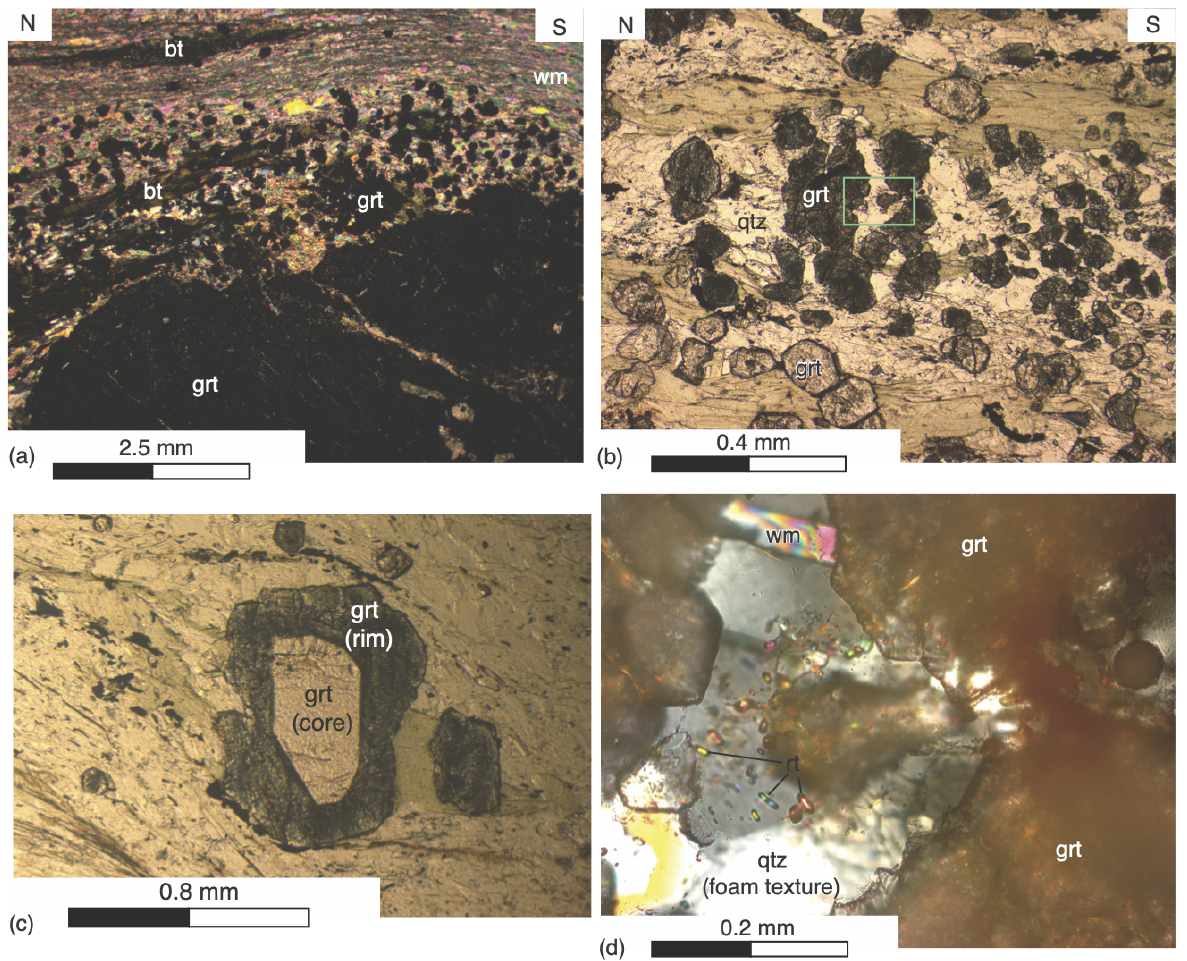
Figure 6. Microstructure analysis in the garnet–mica schist tectonic slice (sample IO17-03). (a) White-mica-dominated deformation fabric with minor biotite relict of early fabric surrounds large 2–3cm diameter garnets, with younger 2–3mm garnets grown on the deformation fabric. (b) Thin section under plane-polarised light: two types of small, second-generation garnets with different chemical compositions are identified (see Supplement – EPMA analysis results). (c) A slightly larger ( ∼ 4mm diameter) second-generation garnet with a zoned crystalline texture (thin section under plane-polarised light). (d) Magnified view of the green box in (b) , under cross-polarised light a euhedral second-generation garnet that grew into a quartz foam texture with relict rutile floating in the void